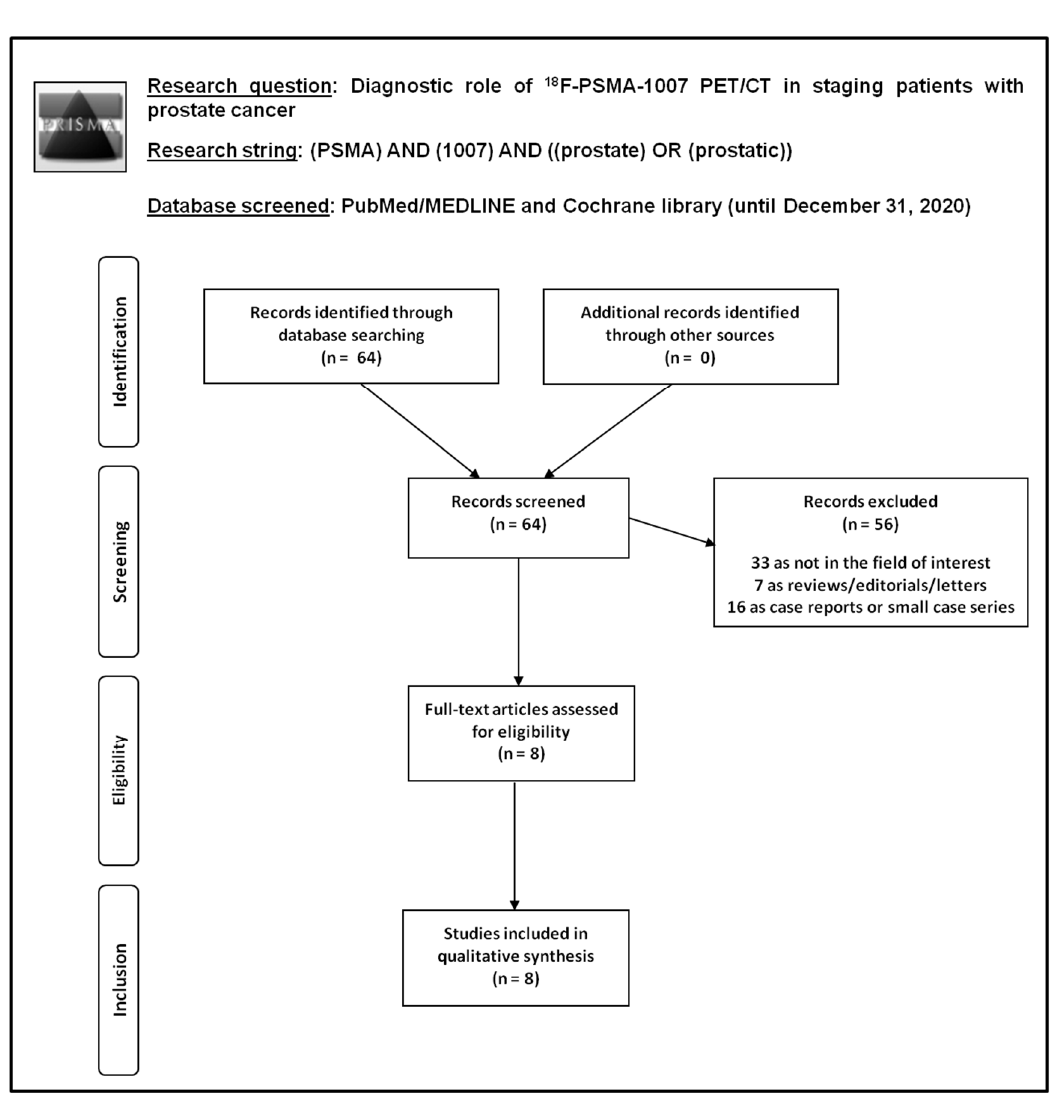
Figure 1. Flow chart of the search for eligible studies on the diagnostic role of 18 F-PSMA-1007 positron emission tomography/computed tomography (PET/CT) in prostate cancer staging. PSMA, prostate-specific membrane antigen.